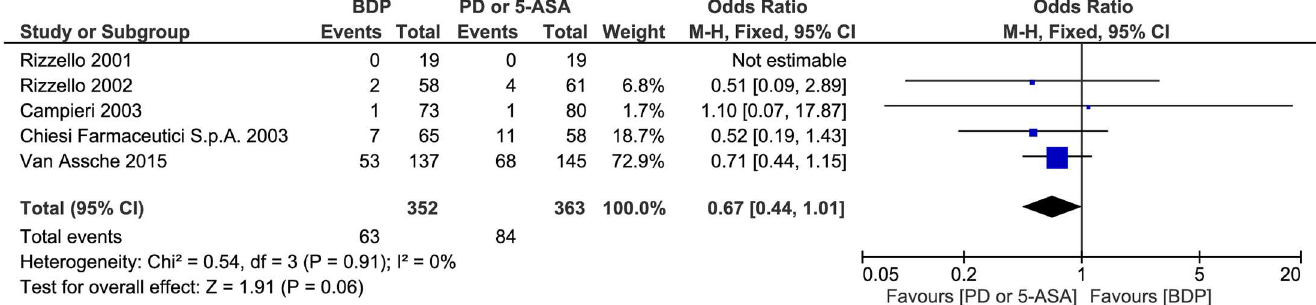
Fig 5. Forest plot of randomized controlled trials of oral BDP vs. oral PD or 5-ASA on adverseevents appearancein ulcerative colitis. BDP, beclomethasone dipropionate. PD, prednisone.5-ASA, mesalazine. M-H, Mantel-Haenszel.